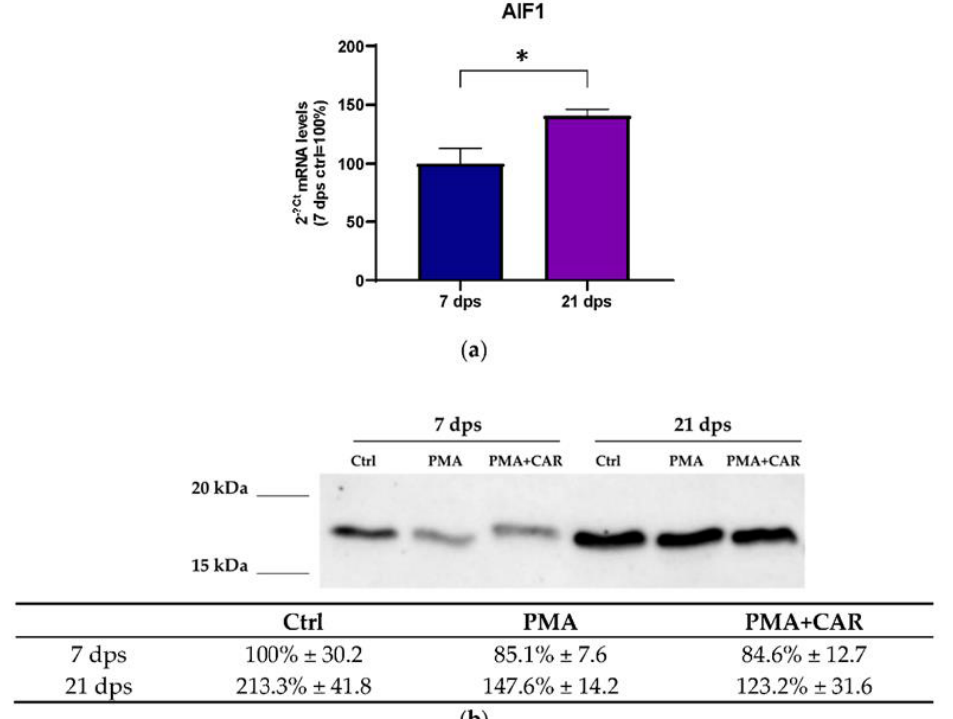
Figure 4. Expression of AIF-1 gene products in Caco-2 cells exposed to PMA (150 nM) and PMA+CAR (1 mM). ( a ) mRNA expression analysis by qPCR on total RNA extracted from 7 dps and 21 dps Caco-2 monolayers. Amounts of the target AIF-1 mRNA were calculated as 2 −ΔCt mean values obtained from two rounds of real-time PCR assays for each of three independent biological replicates (see Materials and Methods for details) and normalized with respect to the GAPDH mRNA (housekeeping). Values are expressed as a percent with respect to the control mean value at 7 dps (100%). Statistical analysis: two-tailed unpaired Student’s t -test (* p < 0.05). ( b ) Representative image of Western Blot assays performed using a specific antibody against the human AIF-1 protein product (~17 kDa) on protein extracts from 7 dps and 21 dps Caco-2 monolayer in the absence (Ctrl) or the presence of PMA and PMA+CAR for 48 h; molecular weight marker is shown on the left (Bio-Rad Precision Plus Protein All Blue Standard, cat. no. #161-0373). For quantitation, densitometric values are normalized with respect to total lane protein (Bio-Rad Image Lab software version 6.1). Data are presented as mean ± SEM of three independent biological replicates and then expressed as a percent with respect to the control mean value at 7 dps (Ctrl = 100%) in the table and graph. Statistical analysis: one-way ANOVA with Dunnett correction for multiple comparisons.